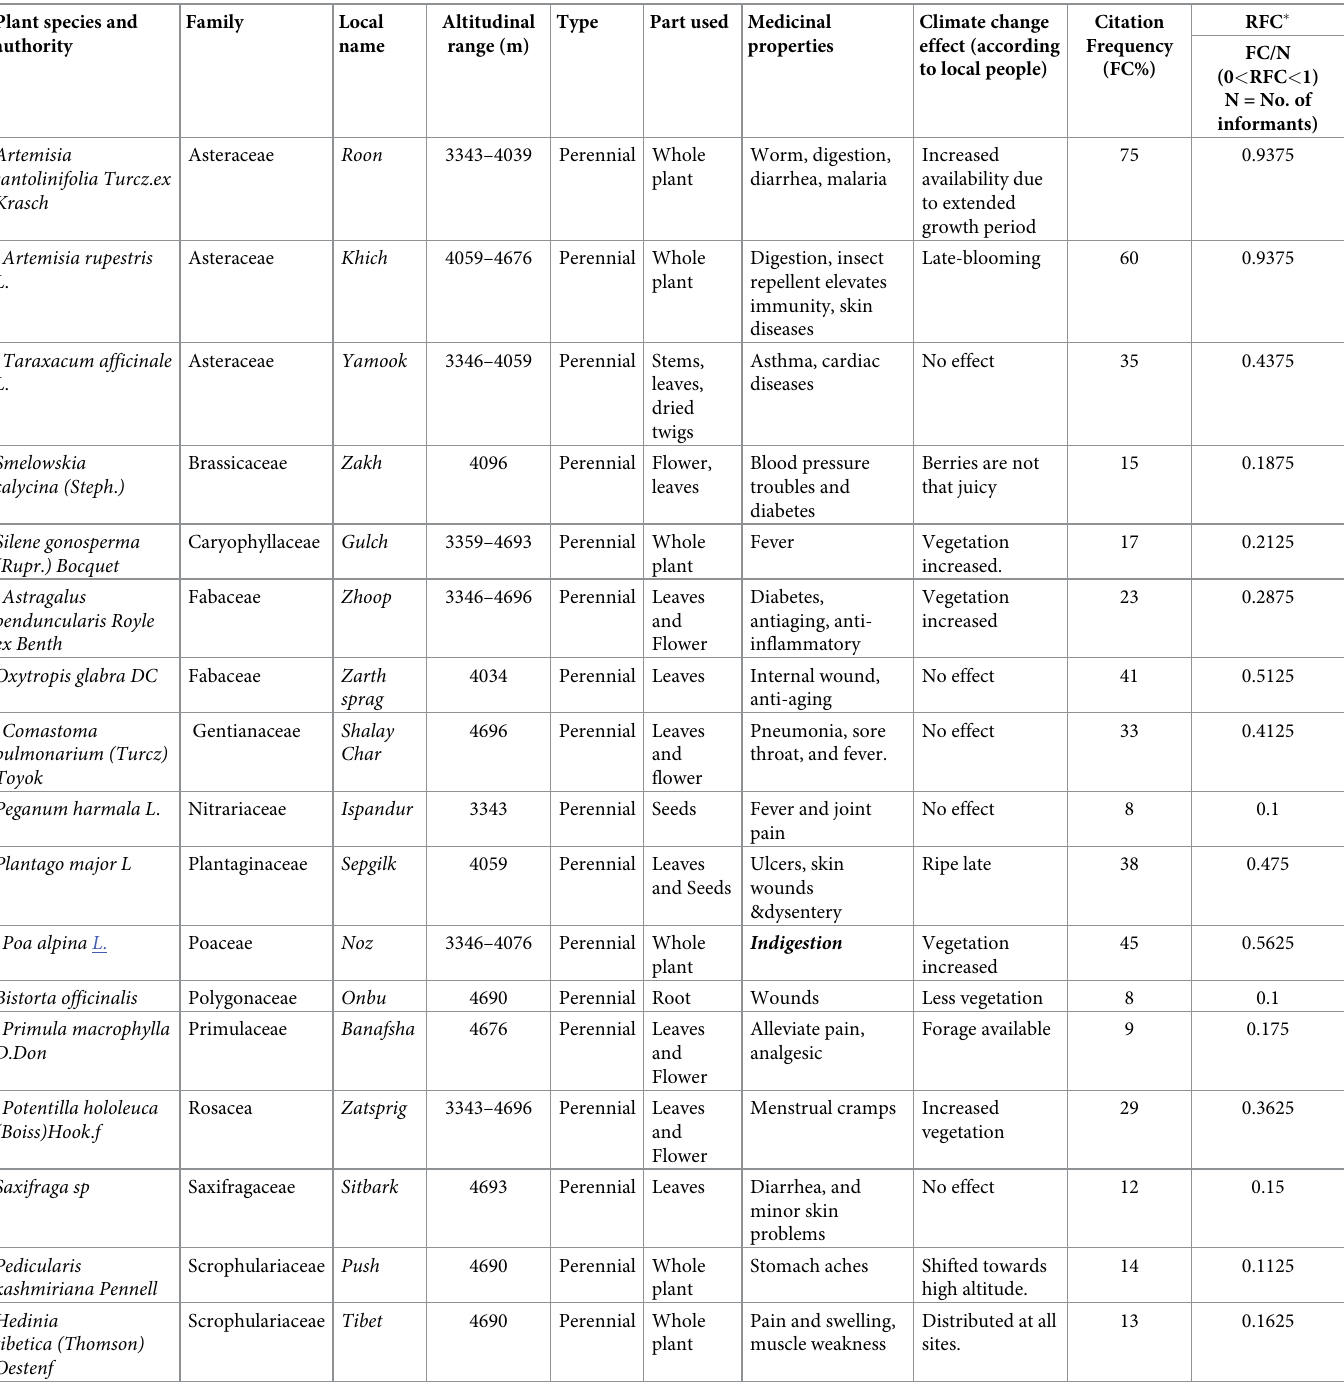
Table 1. Ecological and ethnobotanical properties of selected medicinal plant species. Plant species and